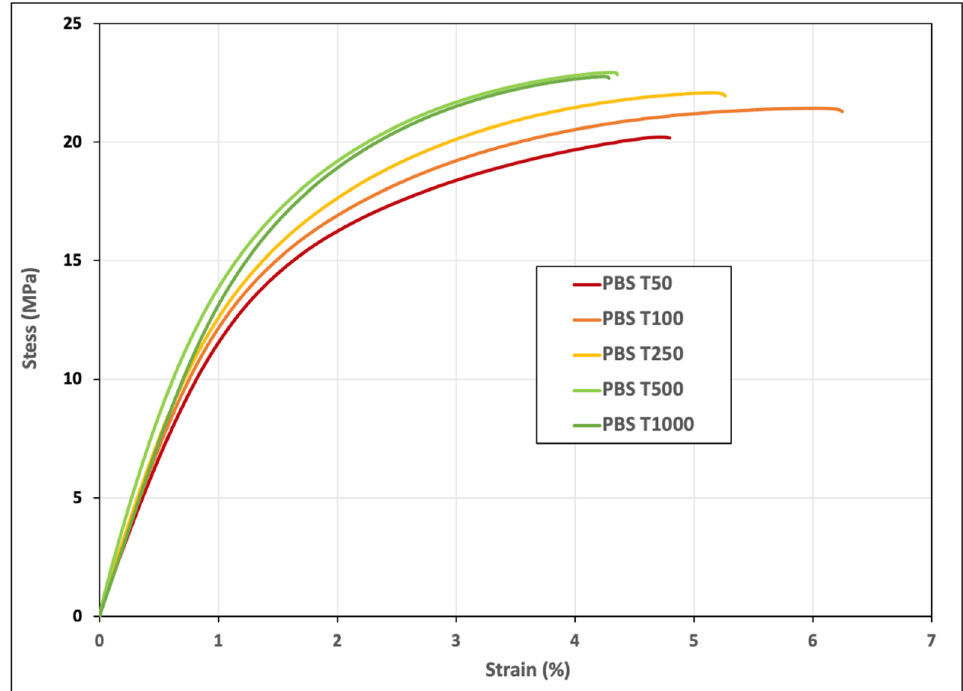
Figure 4. Stress–Strain behavior of PBS–tomato biomass composite materials.